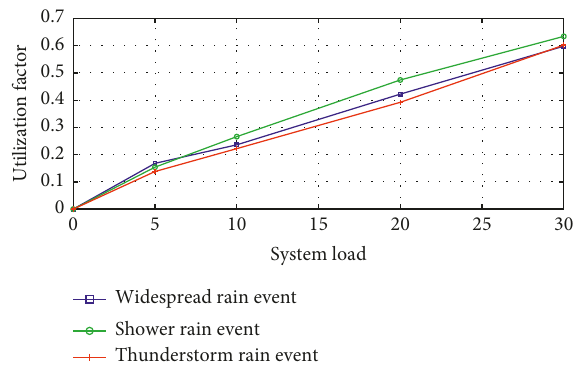
Figure 13: Utilization (four-period prediction).